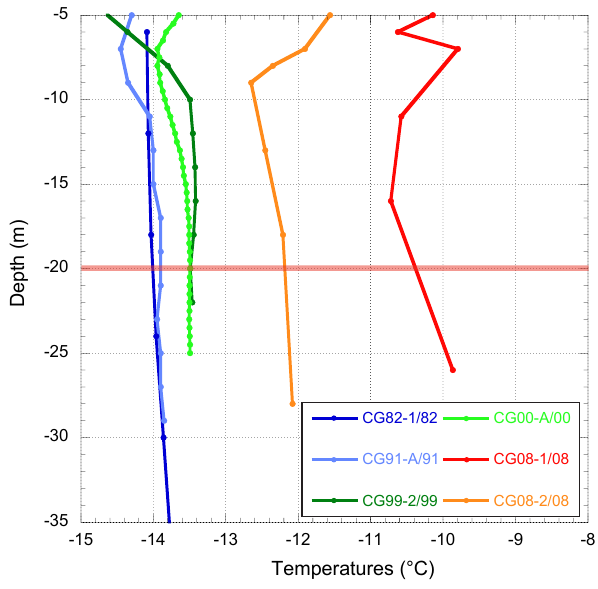
Fig. 4. Temperatures measured at CG82-1/82 (Haeberli and Funk 1991), CG91-A/91 (Laternser 1992), CG99-2/99 and CG00-A/00 (Suter 2002) compared with the new measurements at CG08-1/08 and CG08-2/08 at Colle Gnifetti shown in Fig. 2.